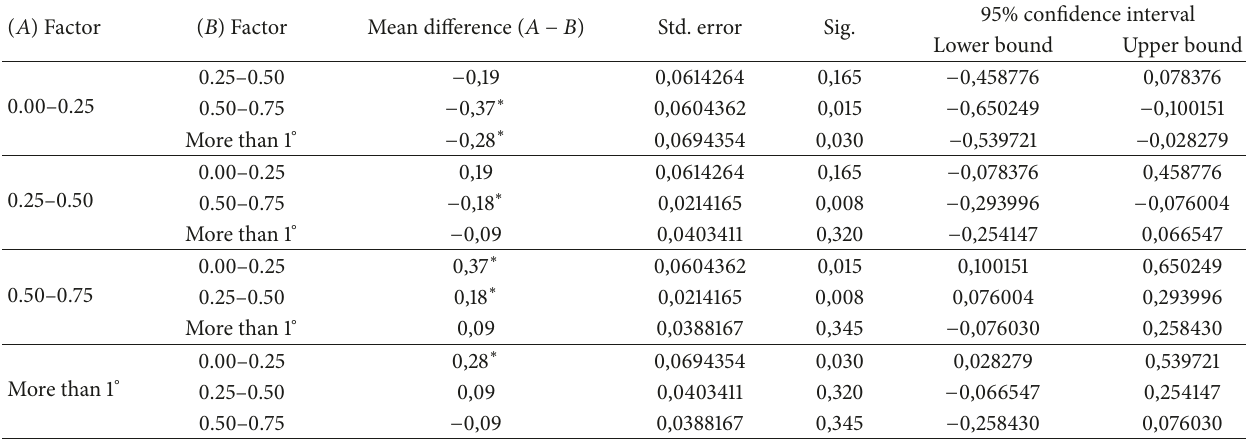
Table 7: Pairwise comparison of standardized coefficients of distance from sea using Tamhane’s post hoc